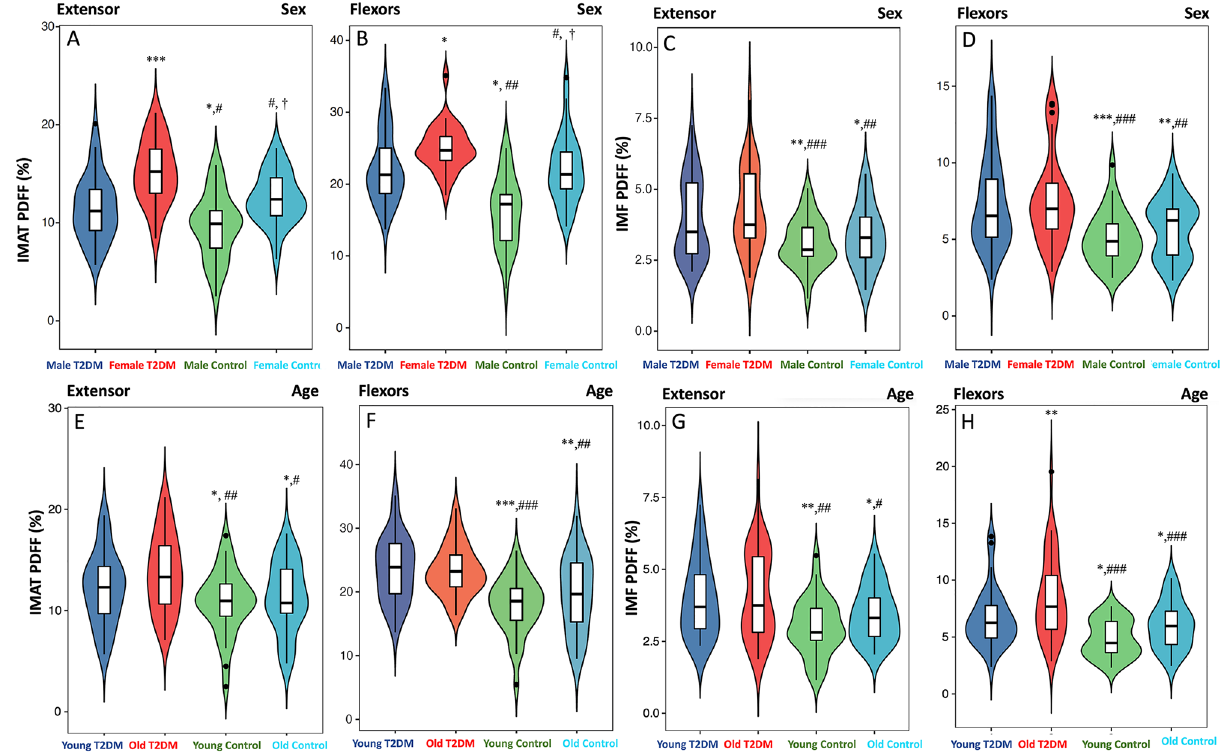
Figure 4. Difference in PDFF of thigh muscle regarding sex and age. ( A , B ) Male and female muscles IMAT PDFF in T2DM patients and control group; ( C , D ) Male and female muscles IMT PDFF in T2DM patients and control group; ( E , F ) Young and old muscles IMAT PDFF in T2DM patients and control group; ( G , H ) Young and old muscles IMT PDFF in T2DM patients and control group; * p < 0.05, ** p < 0.01, *** p < 0.001, vs.